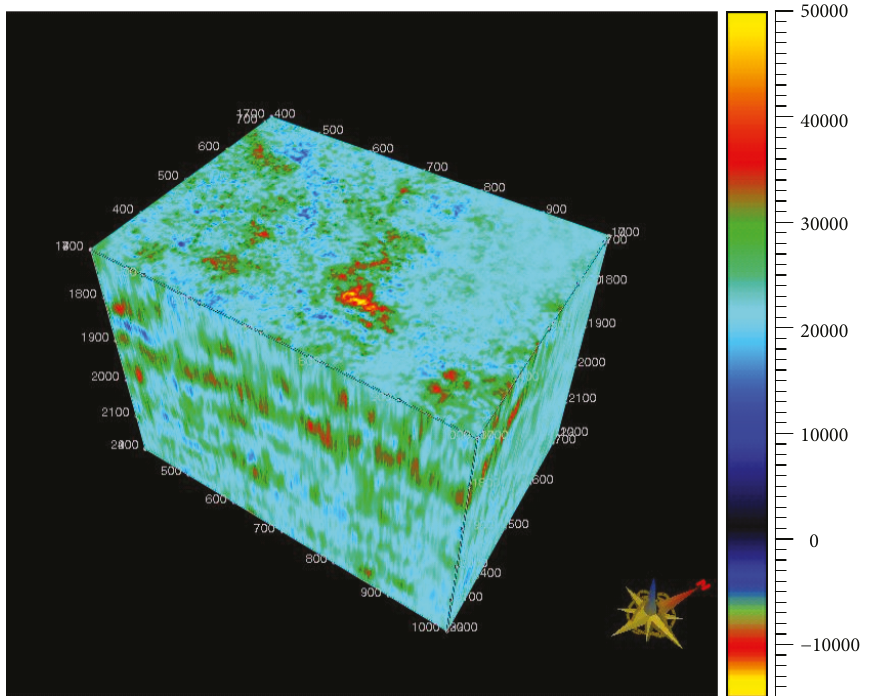
Figure 7: P-wave dispersion gradient of T P-wave dispersion